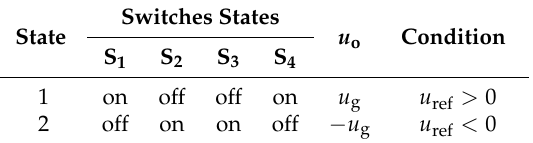
Table 2. Values of u o under different switch states of the second stage. State